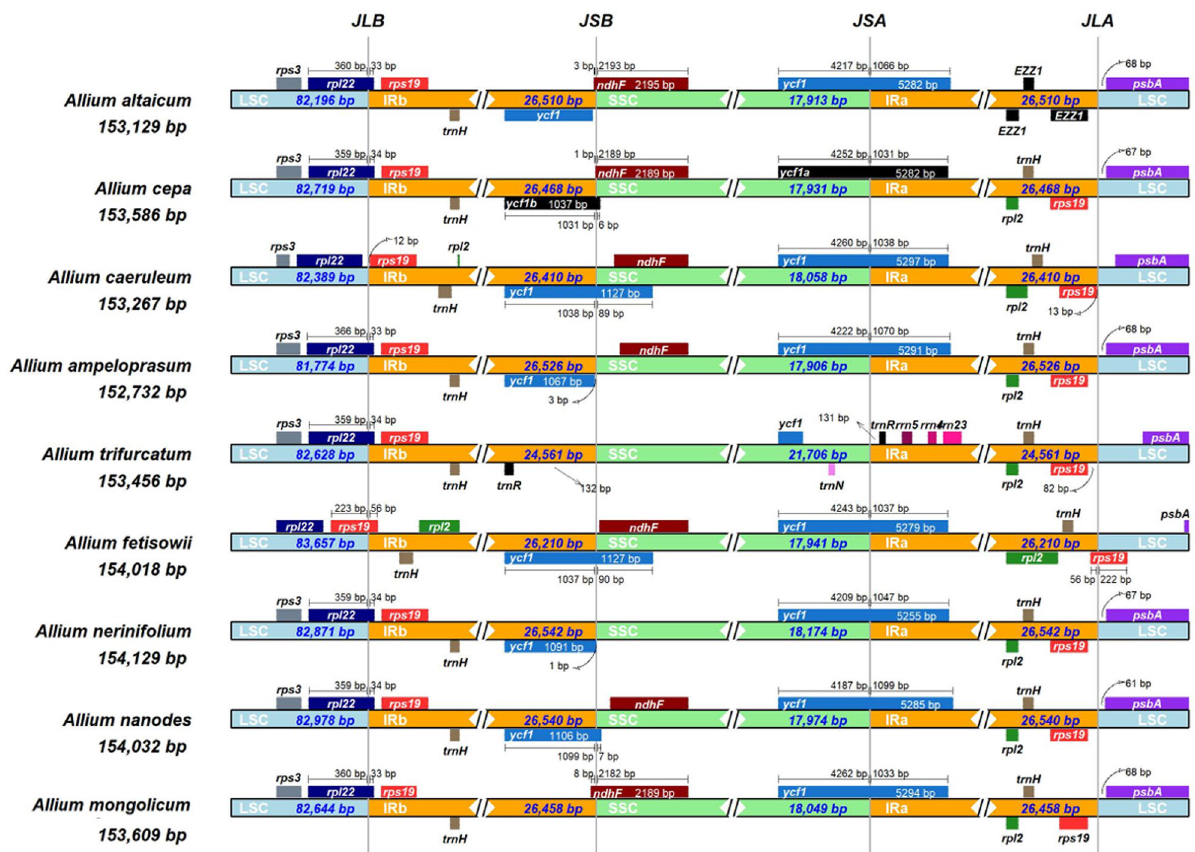
Figure 5. Comparison of the junctions between the LSC, SSC and IR regions among 9 representative Allium chloroplast